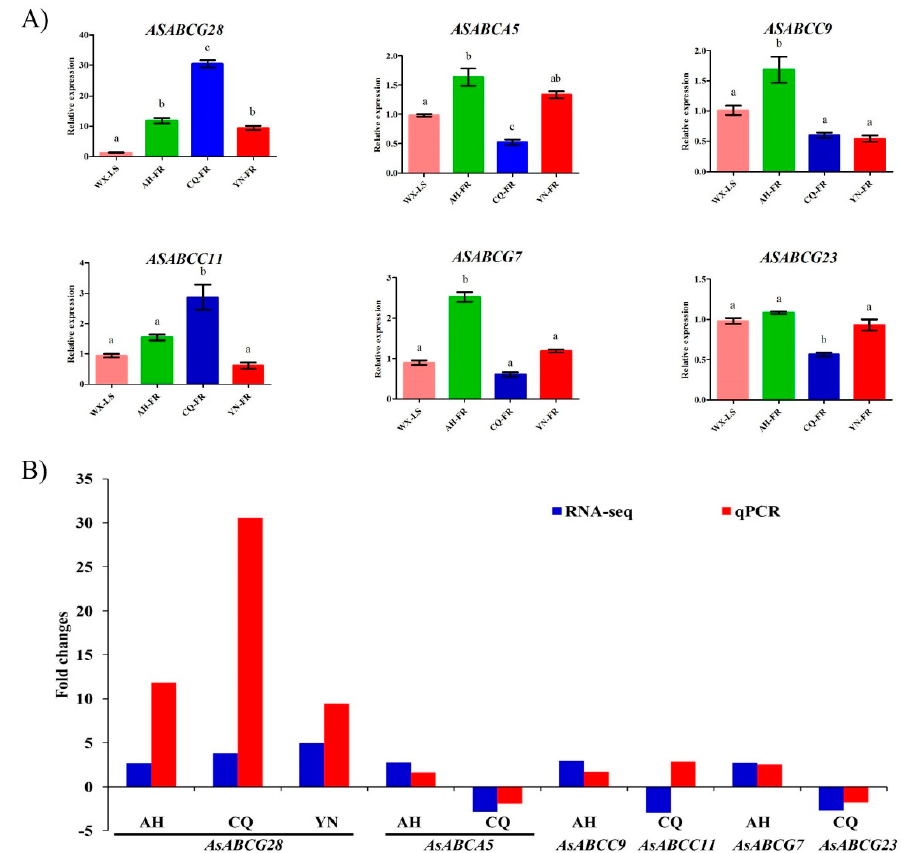
Figure 5. qPCR verification of six genes significantly differentially expressed in RNA-seq analysis. ( A ) The relative expression levels of these genes are shown as the mean ± SD of three biological replicates in qPCR analysis. The S7 (RPS7) and L49 (RPL49) genes were used as internal reference for expression normalization. The population/strain pairs marked with same letters are not significantly different in expression ( p -value ≥ 0.05), and the remaining pairs are significantly different ( p -value < 0.05), determined by one-way ANOVA. ( B ) Comparison of expression fold-changes between RNA-seq and qPCR analyses for the six genes in three field populations comparative with the